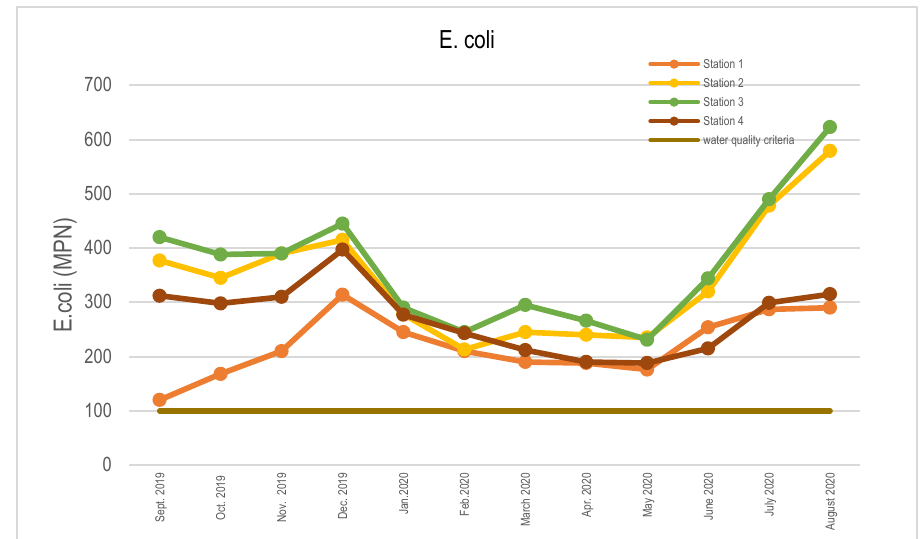
Fig. 5: Measured E. coli in the four sampling stations